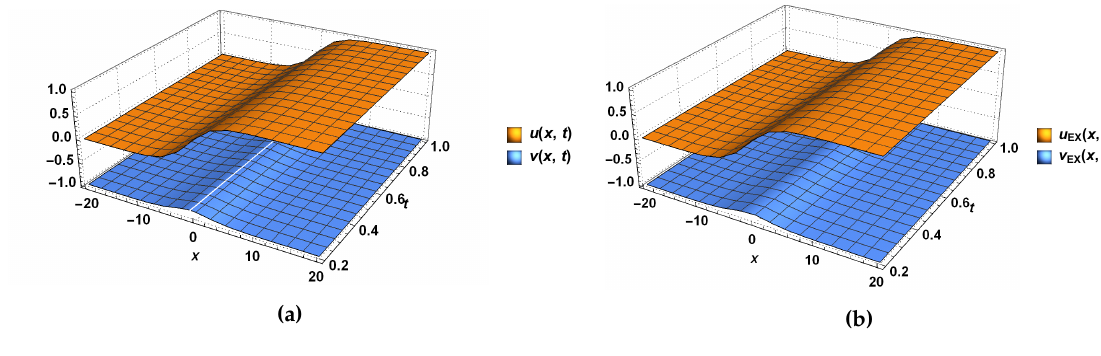
Figure 1. ( a ) The graph for the approximate solution of Example 2 for α = β = 0.5 and q 1 = q 2 = 1; ( b ) The graph for the exact solution of Example 2 for α = β =